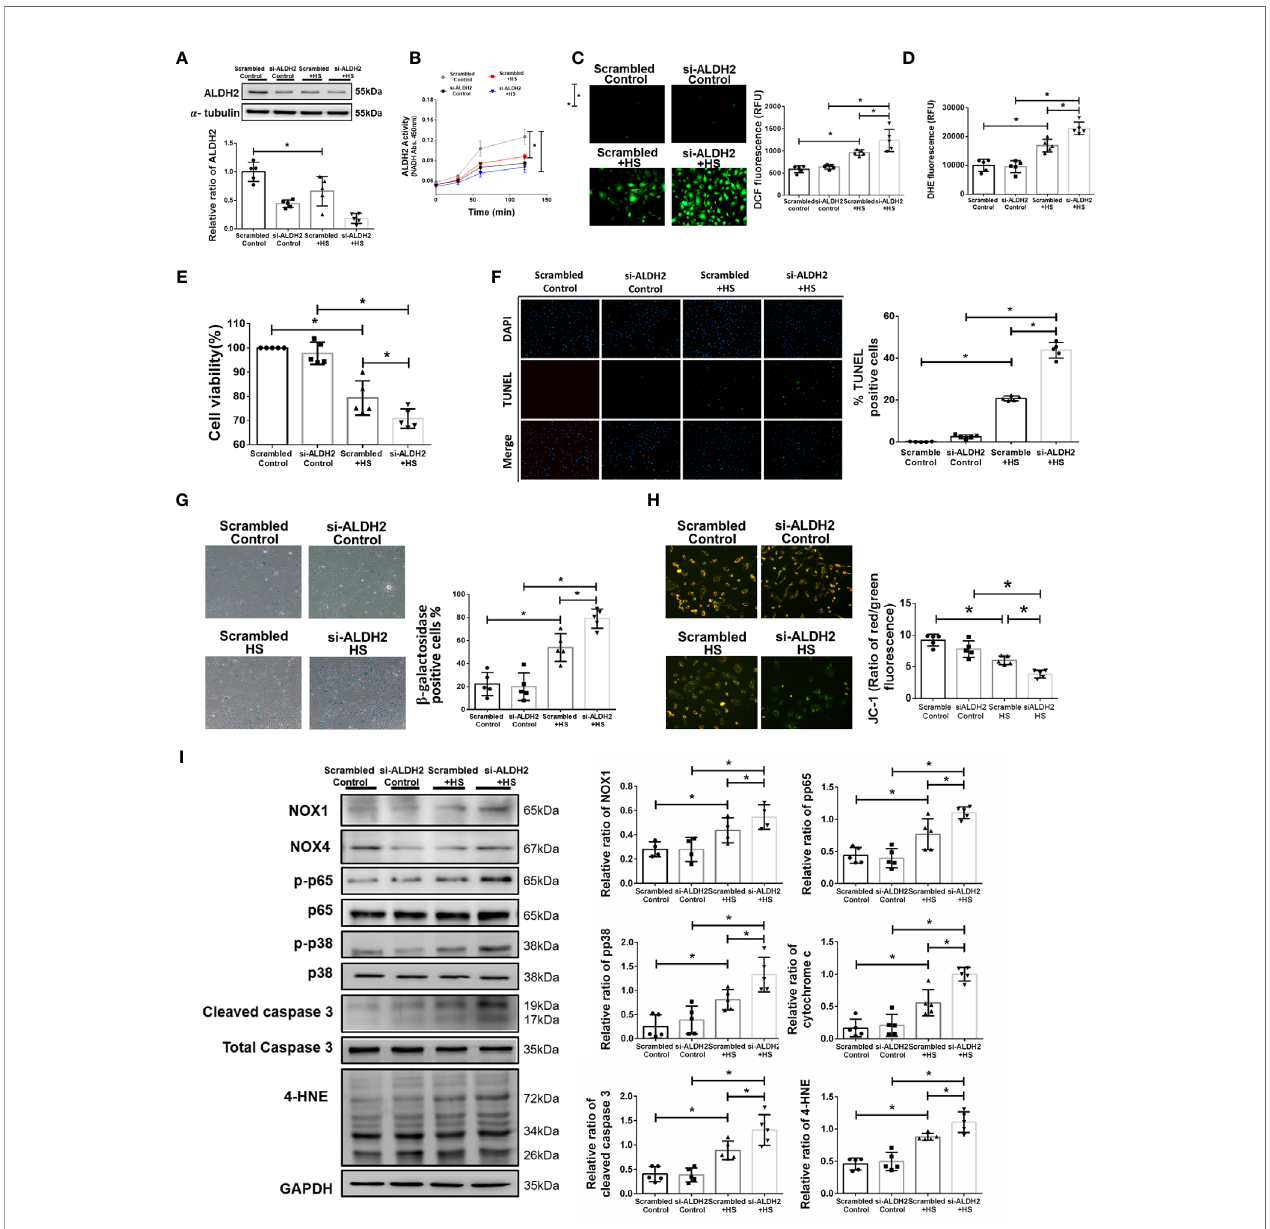
FIGURE 2 | Silencing ALDH2 augmented heat stress-induced activation of NF- k B, ROS production and apoptosis in HUVECs in vitro. HUVECs were transfected with ALDH2 siRNA or control siRNA (scramble) before heat stress induction (42°C for 2 h). (A) ALDH2 protein expression was measured by immunoblotting ( n = 5). (B) The ALDH2 activity in cell lysate was determined by measuring NADH production based on the O.D. absorbance at 450 nm in a microplate reader ( n = 5). (C) Measurement of ROS production based on DCF fl uorescence using a fl uorescence microplate reader with an excitation wavelength of 488 nm and an emission wavelength of 535 nm ( n = 5). (D) Measurement of cellular ROS production based on DHE fl uorescence using a fl uorescence microplate reader with an excitation wavelength of 518 nm and an emission wavelength of 606 nm ( n = 5). (E) The viability of HUVECs was measured by the MTT assay based on the O.D. absorbance at 570 nm in a microplate reader ( n = 5). (F) The levels of apoptosis were measured by the TUNEL assay as determined fl uorescence microscopy. The percentage of apoptotic cells was determined based on the number of TUNEL-positive cells among the total number of cells ( n = 5). (G) The levels of senescence were measured by b -galactosidase activity detection using bright fi eld microscopy ( n = 5). (H) Detection of mitochondrial dysfunction by the JC-1 assay, revealing a decrease in the mitochondrial membrane potential ( DY m) in live cells as determined by fl uorescence microscopy and fl uorescence microplate reader. The DY m level is expressed as the merge of the red and green channels, and the data were quanti fi ed as the ratio of red fl uorescence intensity to the green fl uorescence intensity ( n = 5). (I) The protein and 4-HNE levels in lung homogenates were measured by immunoblotting. Densitometric analysis was conducted with imaging processing software. The data were quanti fi ed by normalization to GAPDH; phosphorylated proteins were normalized to total proteins ( n = 5). The data are expressed as the mean ± SD. Statistical signi fi cance is indicated as * p <